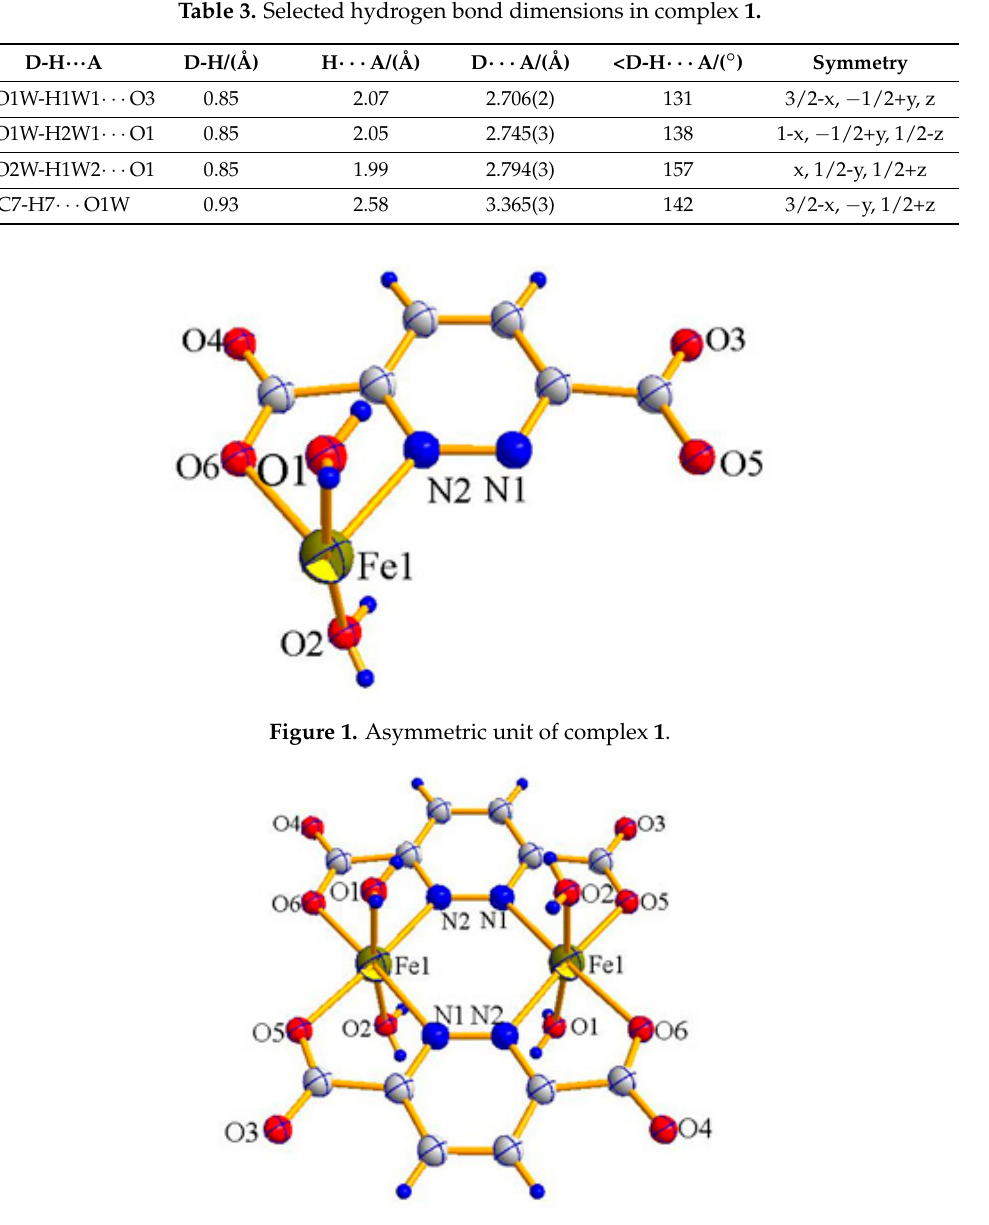
Figure 2. Molecular structure of complex 1 .